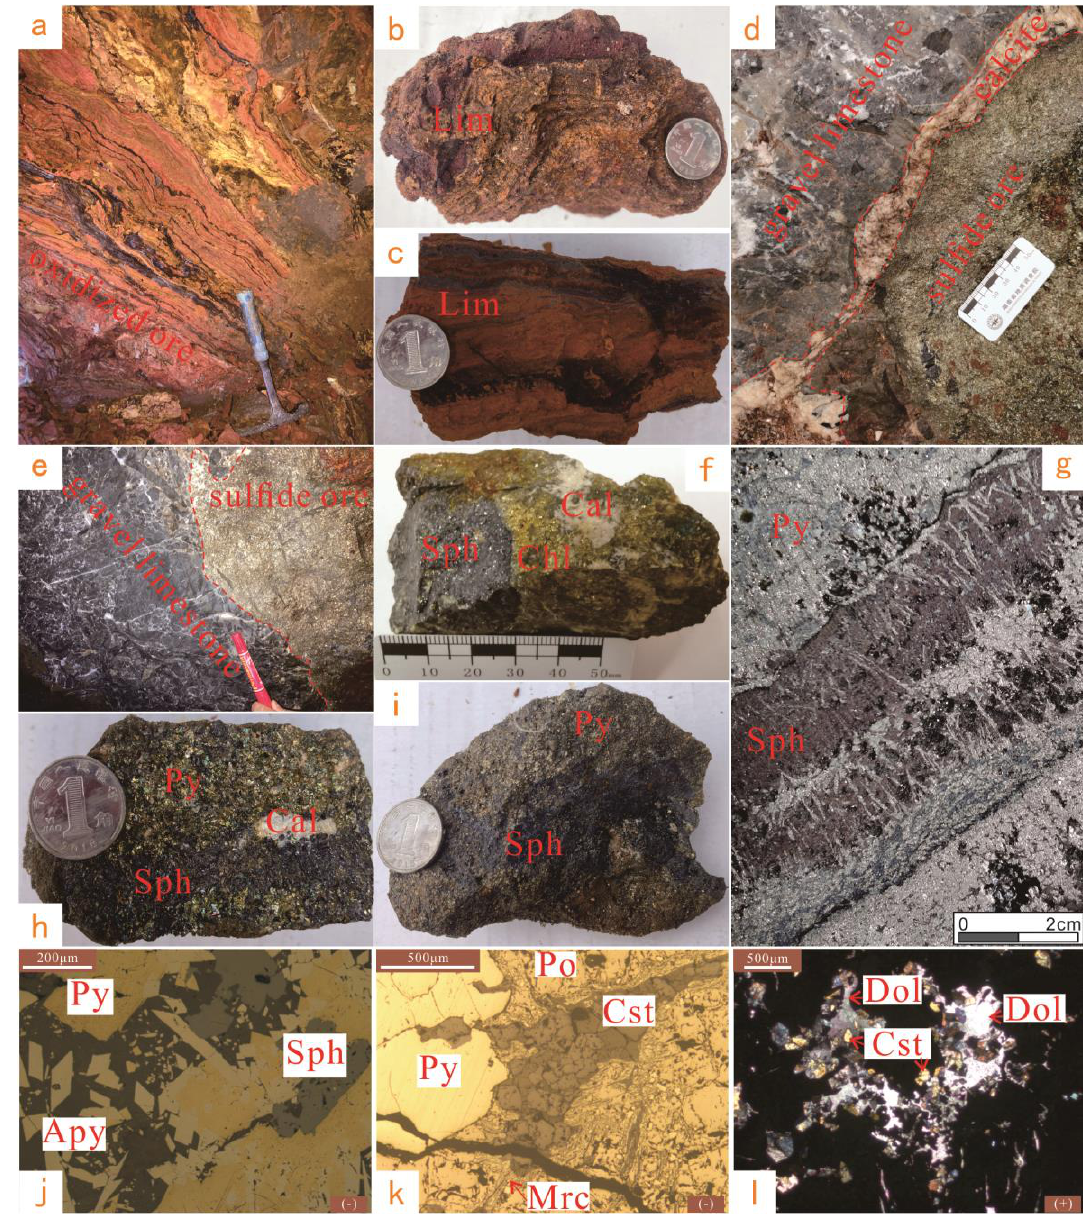
Figure 4. Typical photos of the Bawang deposit: ( a – c ) the oxidized ore; ( d , e ) the sulfide ore has a clear boundary; ( f – i ) metal minerals; ( j ) pyrite and arsenopyrite associated with sphalerite; ( k ) pyrite, pyrrhotite, and marcasite associated with cassiterite; ( l ) the edge of the dolomite dotted with cassiterite. Abbreviations: Lim = limonite, Cal = calcite, Sph = sphalerite, Chl = chalcopyrite, Py = pyrite, Apy = arsenopyrite, Po = pyrrhotite, Cst = cassiterite, Mrc = marcasite, Dol = dolomite.